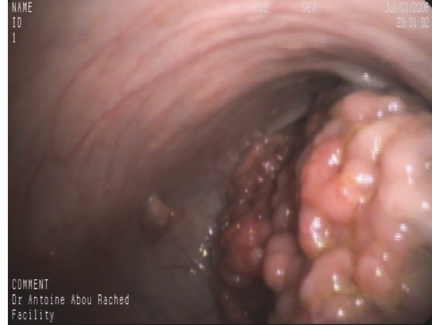
Figure 1: GIP of left colon. Figure 2: Obstructive GIP of the splenic flexure.